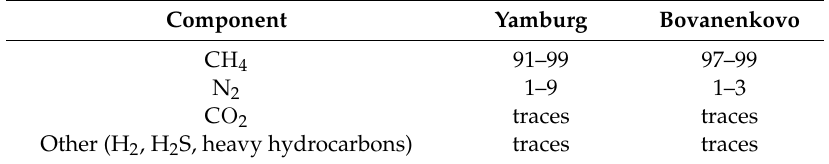
Table 1. Molecular (component) composition of permafrost gas samples (% vol., ranges).